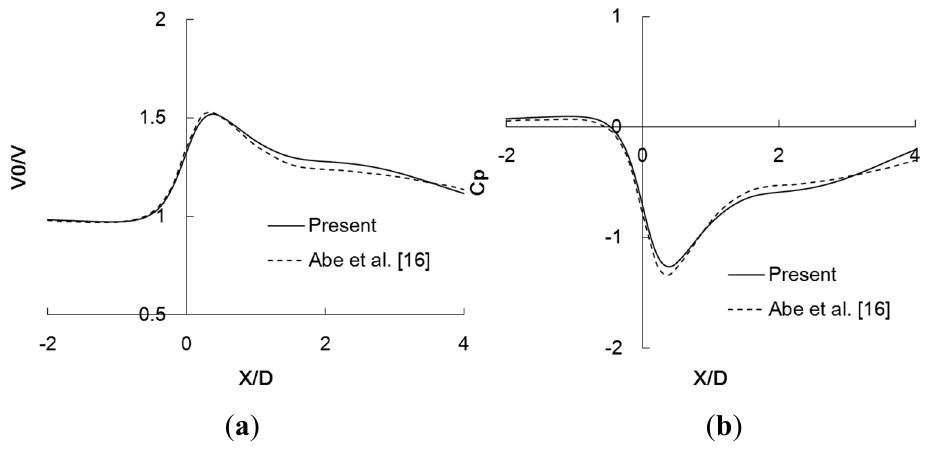
Figure 11. Streamwise velocity and pressure coefficient along the axisymmetric axis in the present comparative simulation are compared with those obtained from the previous research Abe et al. [16] ( V 0 = 5 m/s, D = 0.2 m, L = 1.5 D , h = 0.5 D , ϕ =